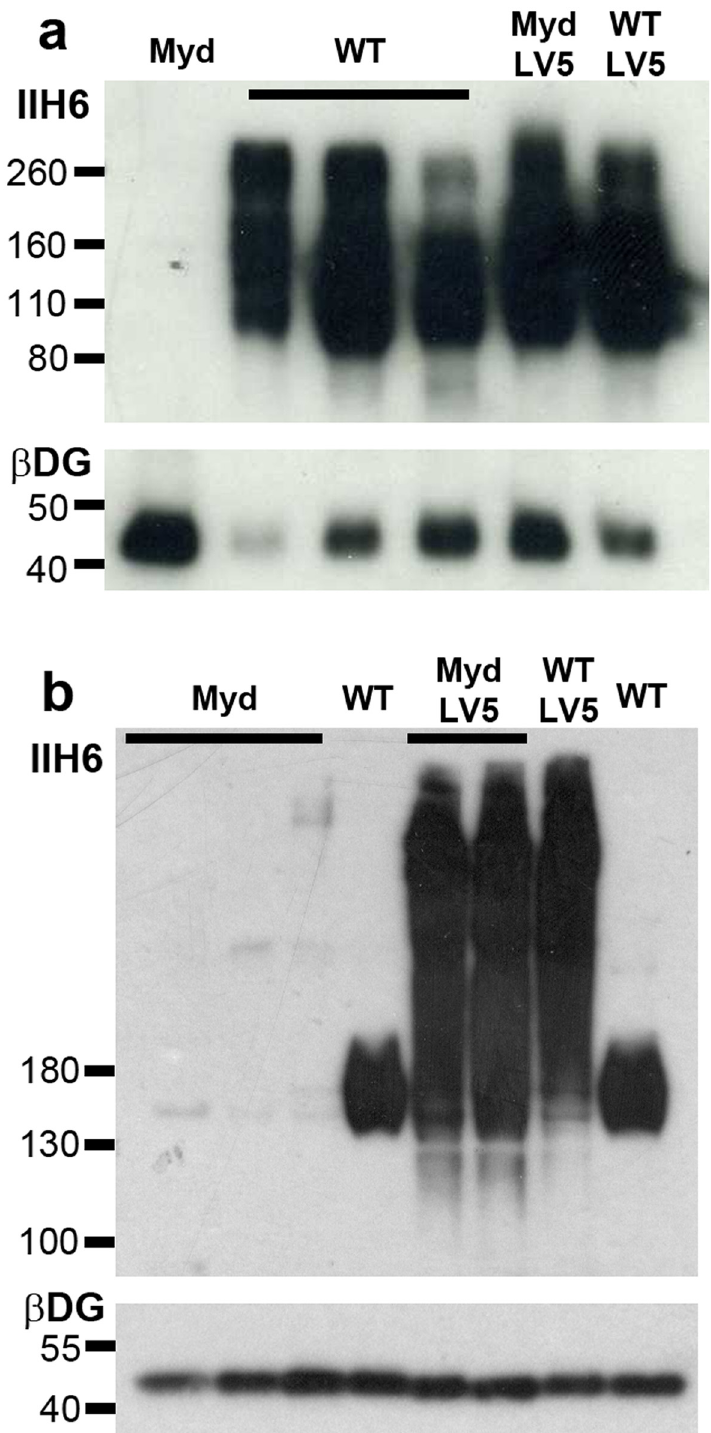
Fig 1. The LARGE-LV5 transgene restores IIH6 reactivity, and causes marked hyperglycosylation in muscle. IIH6 western blot of tissue lysates from brain (a) and quadriceps muscle (b) of WT and LARGE myd mice with or without the LARGE-LV5 transgene (as indicated). β -dystroglycan included as loading control.